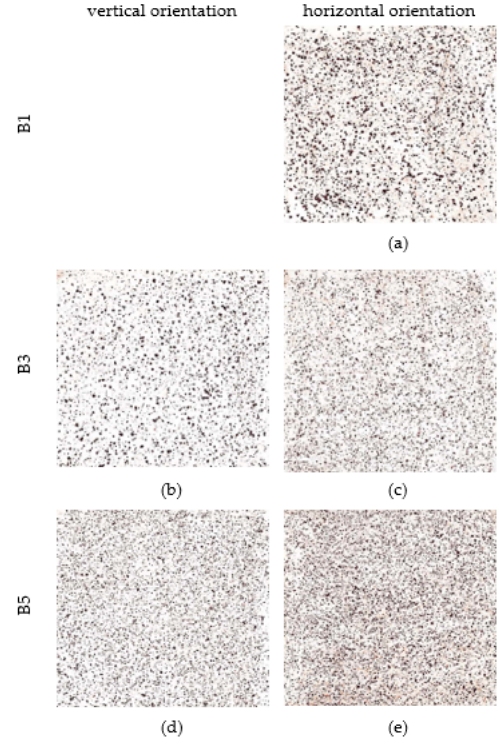
Figure 12. Scotch tape test (area 70 × 70 mm). ( a , c , e ) Scotch tape test—horizontal orientation of corrosion coupons from stand B1, B3 and B5 ( b , d ) Scotch tape test—vertical orientation of corrosion coupons from stand B3 and B5.